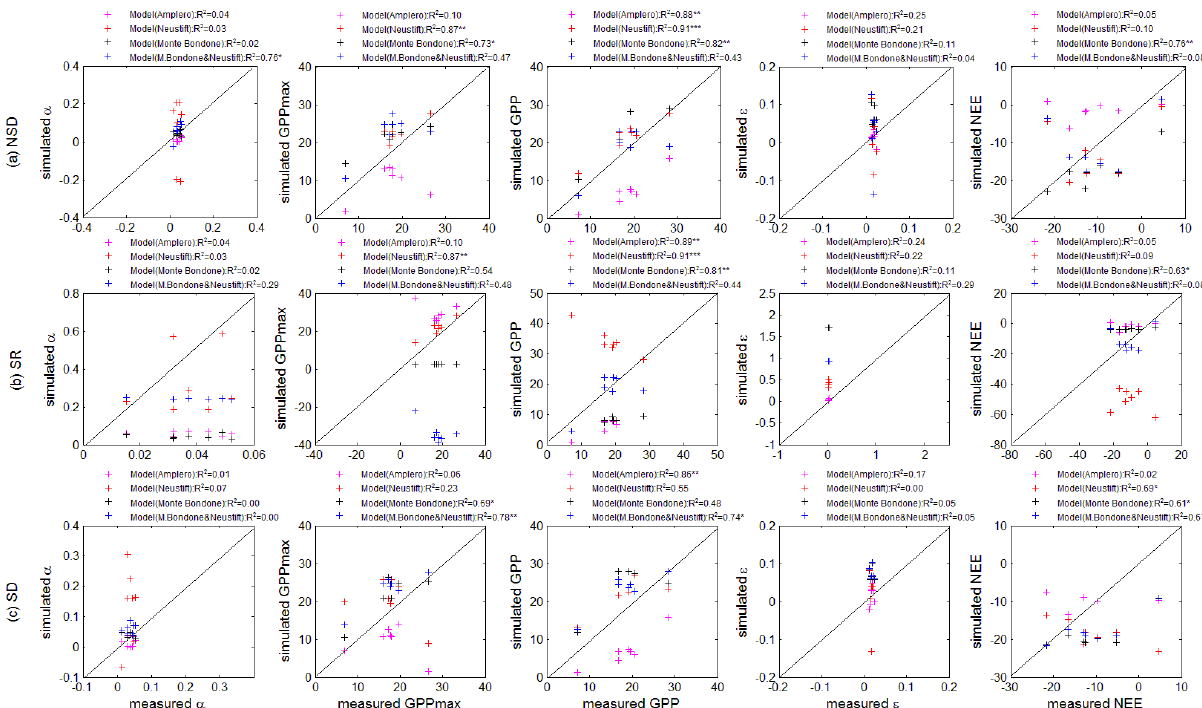
Figure 7. Results of validation of linear regression models between VIs ( (a) NSD-type; (b) SR-type; (c) SD-type) and ecophysiological parameters: α , ε (midday average), GPP max and midday average CO 2 fluxes (NEE and GPP). R 2 – coefficient of determination. Different colours represent results of the validation performed applying to the three new sites the model for Amplero (in magenta), Neustift (in red) and Monte Bondone (in blue) and a model-parameterized grouping Monte Bondone and Neustift (M.Bondone&Neustift; in black). Statistical significance is indicated as ∗ ( p < 0 . 05), ∗∗ ( p < 0 . 01) and ∗∗∗ ( p < 0 . 001). The black lines are 1 : 1